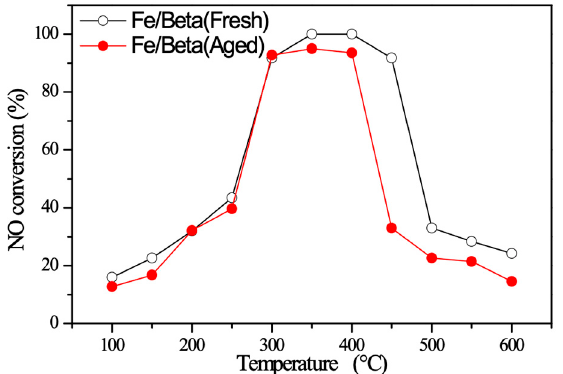
Figure 9. NO conversion over the fresh and aged Fe/Beta(LIE) catalysts. The hydrothermal aging was performed at 700 ◦ C for 24 h in the presence of 10% H 2 O. Reaction conditions are same as those in Figure 7.